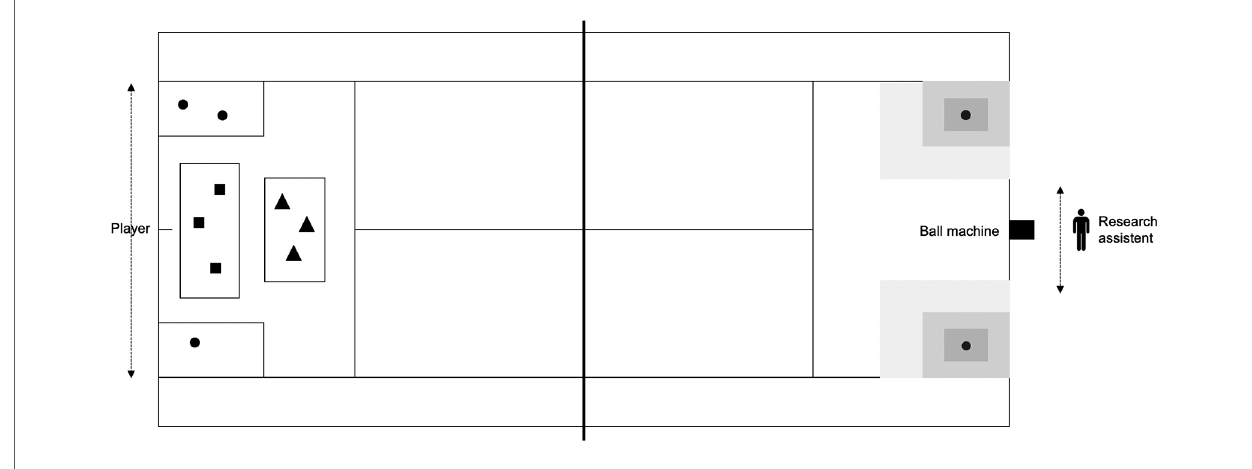
FIGURE 1 Illustration of the D4T with various tactical situations. This fi gure shows the test situation of the D4T with various tactical situations. The symbols represent the three ball projections in an offensive ( ▴ ), neutral ( ▪ ) and defensive ( ● ) tactical situation.